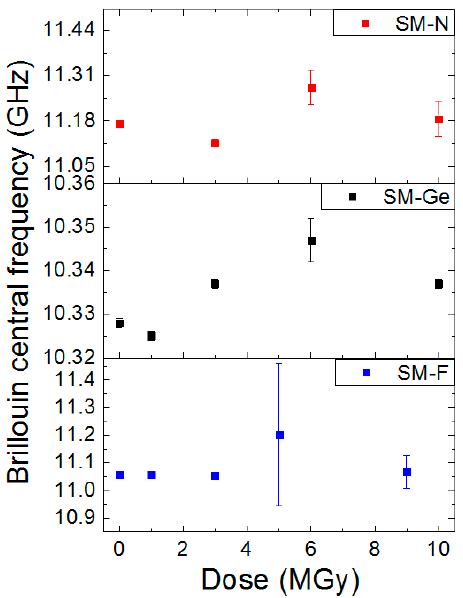
Figure 13. Evolution of the Brillouin central frequency as a function of the irradiation dose for the SM-F, SM-Ge and SM-N fibers. The experiments were done in post-mortem configuration (after the irradiation).